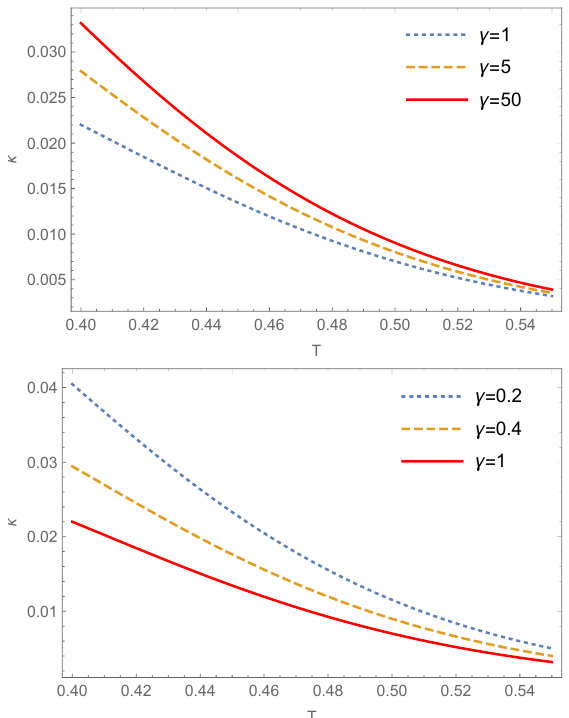
Figure 12 . The dependence of the transition rate of the Hawking-Page phase transition from the large SAdS black hole state to the thermal AdS state on the ensemble temperature T for the exponentially decayed friction kernel. In the plot, L = 1 , ζ = 5 , and ˜ ω = π